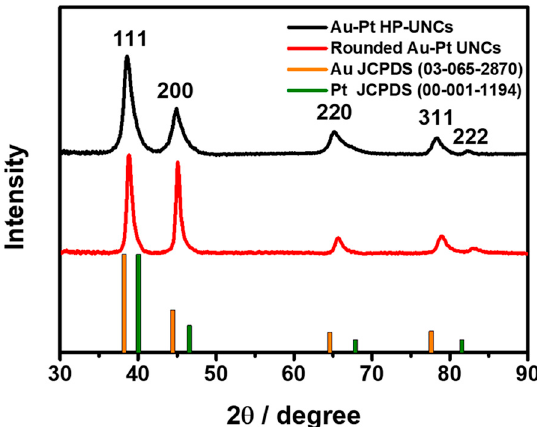
Figure 5. X-Ray Diffraction (XRD) pattern of Au–Pt HP-UNCs and rounded Au–Pt UNCs. The positions of Au and Pt were taken from the JCPDS database.